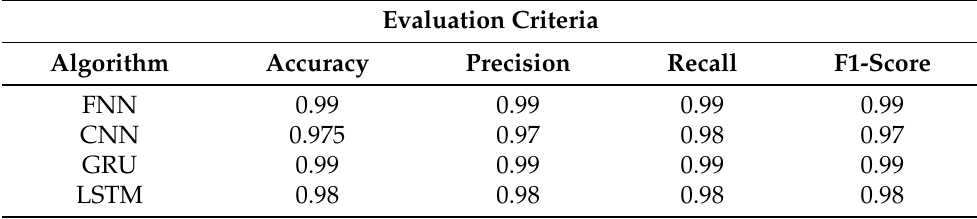
Table 2. Algorithms’ evaluation criteria.